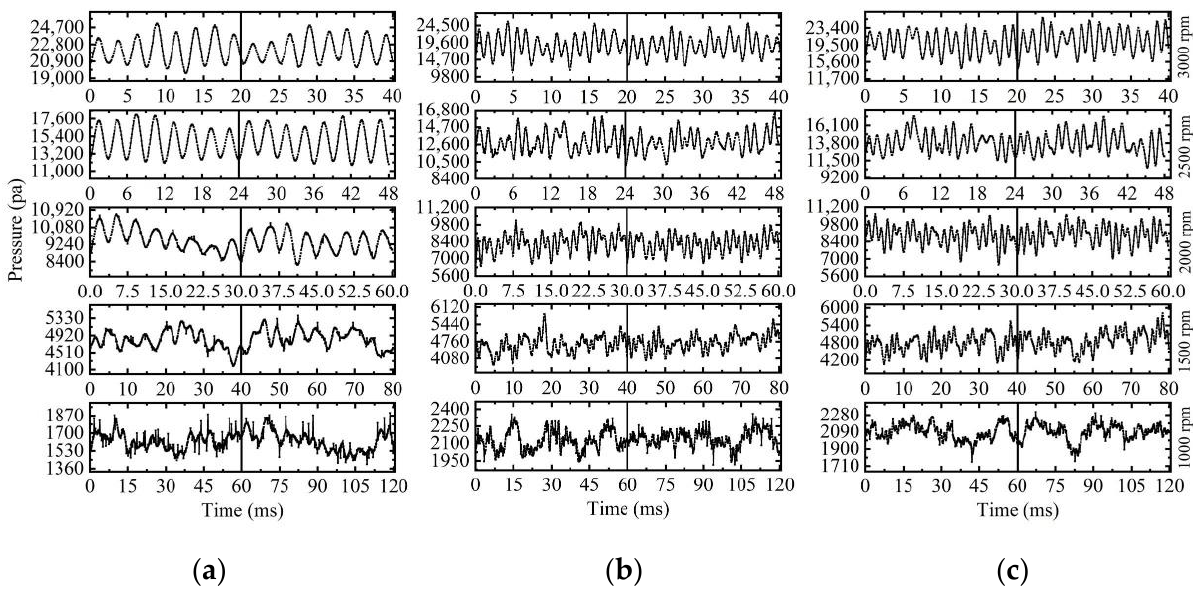
Figure 10. Time domain of pressure pulsation for three volutes at different impeller speeds. ( a ) Single-tongue volute; ( b ) double-tongue volute (static); ( c ) double-tongue volute (rotate).